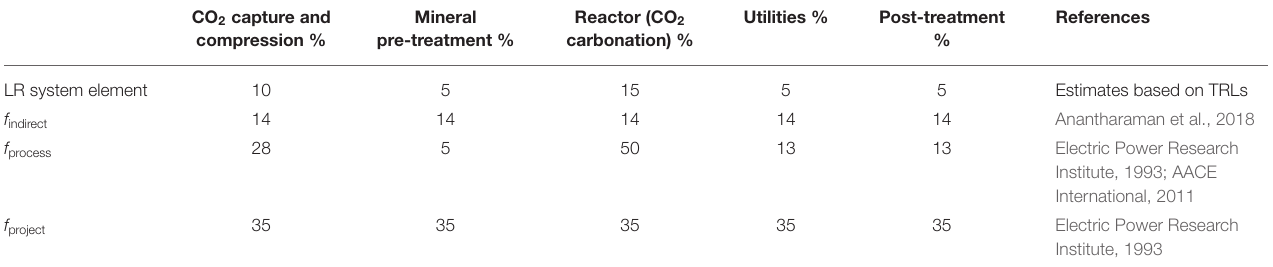
TABLE 5 | Assumed indirect costs, contingencies, and learning rates for system elements (guidelines for deriving process and project contingencies are shown in Tables 3 , 4 ).